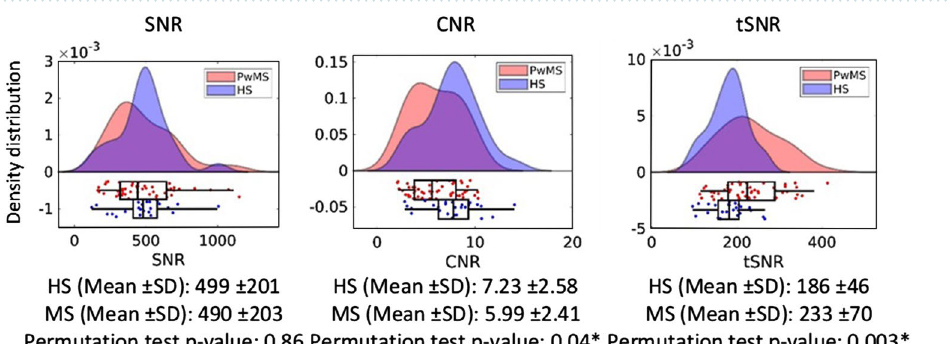
Figure 4. Group distributions of scanning quality (SNR) and signal quality (tSNR and CNR) of the fMRI scans in standard space. * indicates statistical significance (p < 0.05).